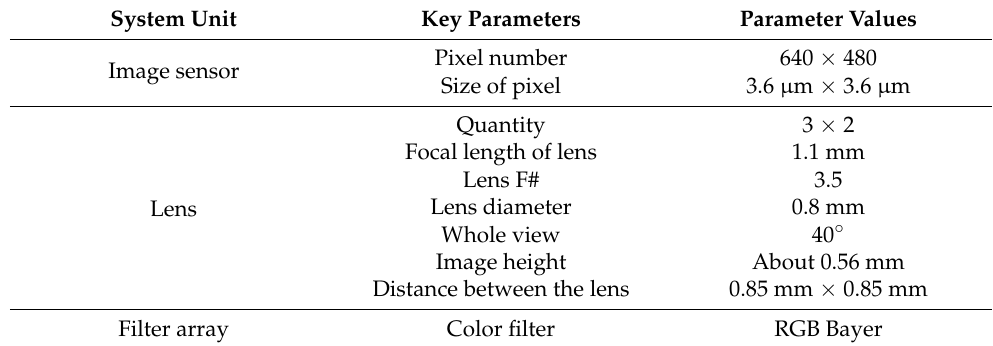
Table 5. Parameters of the TOMBO endoscope prototype.